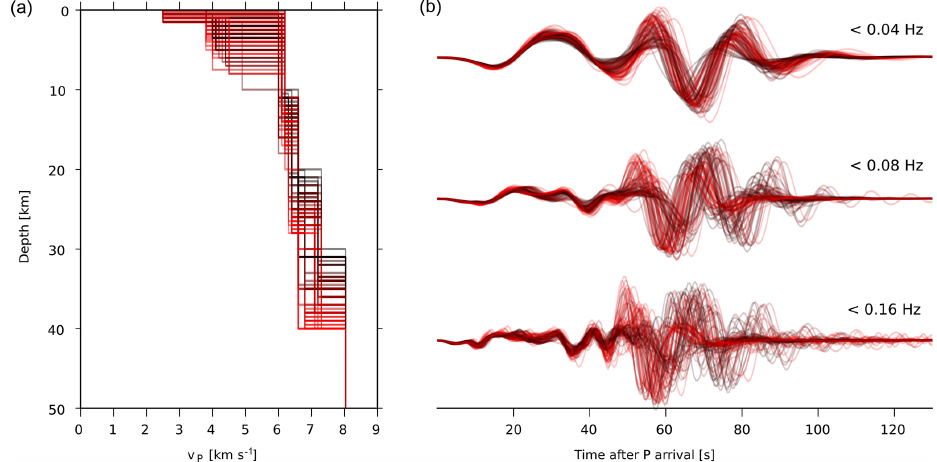
Figure 6. Illustration of waveform sensitivities caused by crustal velocity variations. (a) Colour-coded crustal P-wave velocity profiles as a function of depth. Darker colours correspond to lower crustal thickness. (b) Synthetic, low-pass-filtered seismograms of a double-couple point source corresponding to the P-wave velocity structure in (a) at 278km of